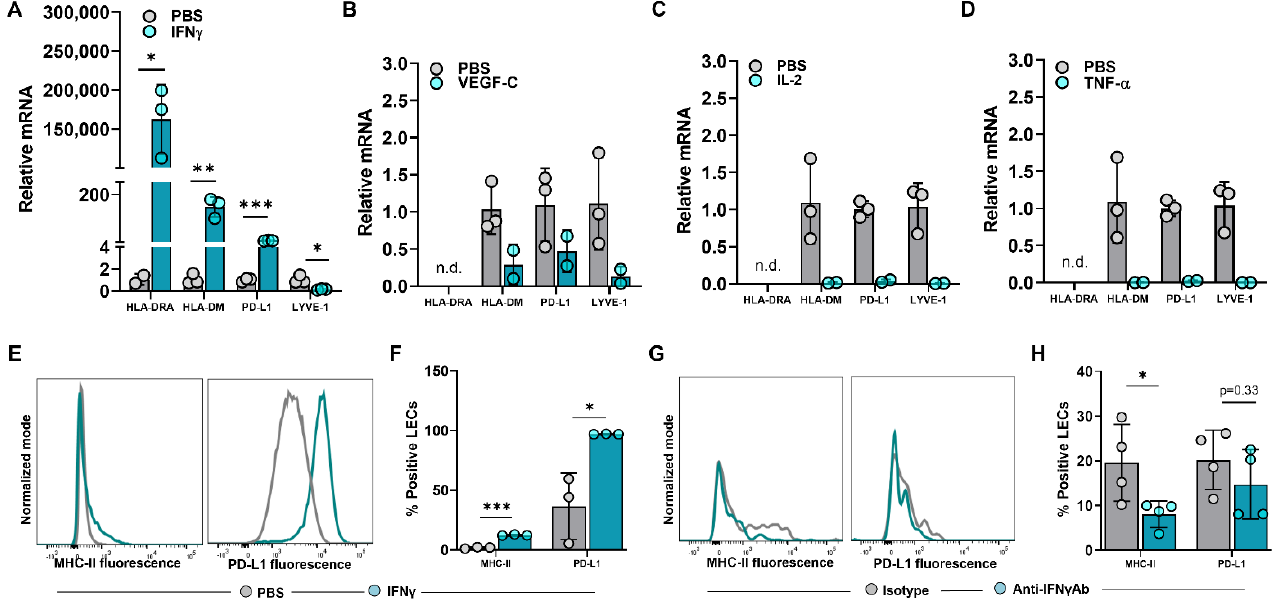
Figure 3. IFN γ induces upregulation of MHC − II in LECs in vitro and in vivo in the tumor periphery. ( A – D ) Relative mRNA expression of HLA − DRA, HLA − DM, PD − L1, LYVE − 1 in cultured human dermal LECs after 24-h treatment with ( A ) IFN γ (100 ng/mL), ( B ) VEGF − C (100 ng/mL), ( C ) IL − 2 (10 ng/mL) and ( D ) TNF − ɑ (10 ng/mL). ( E ) Representative FACS histogram plot and ( F ) quantification